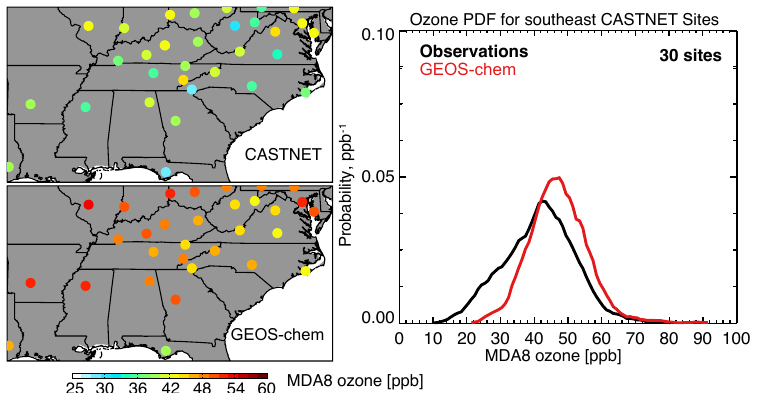
Figure 10. Maximum daily 8h average (MDA8) ozone concentrations at the 30 CASTNET sites in the Southeast US in June–August 2013. The left panels show seasonal mean values in the observations and GEOS-Chem. The right panel shows the probability density functions (pdfs) of daily values at the 30